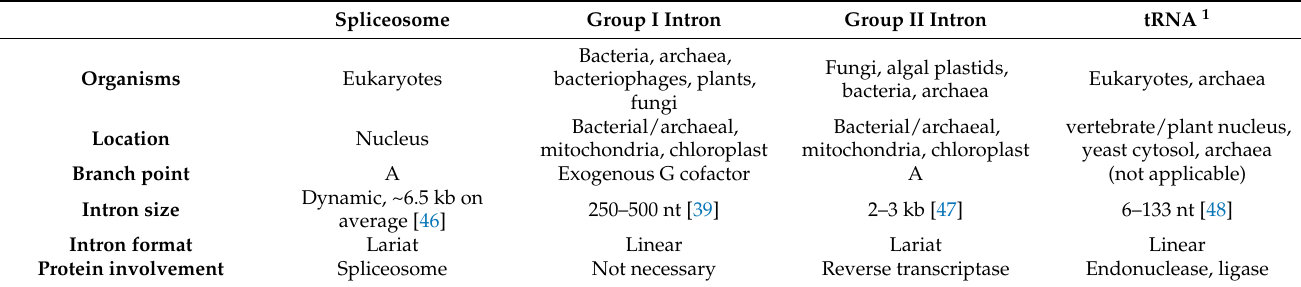
Table 1. Key differences between spliceosome-dependent, group I, group II intron, and tRNA